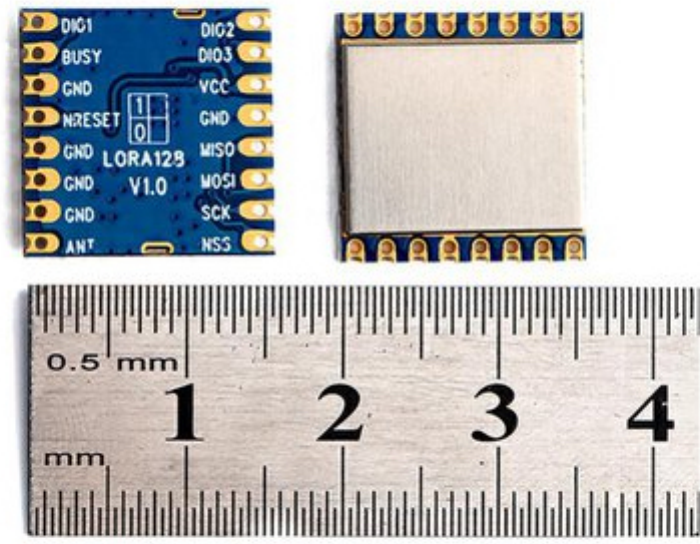
Figure 3. The LoRa 2.4 GHz